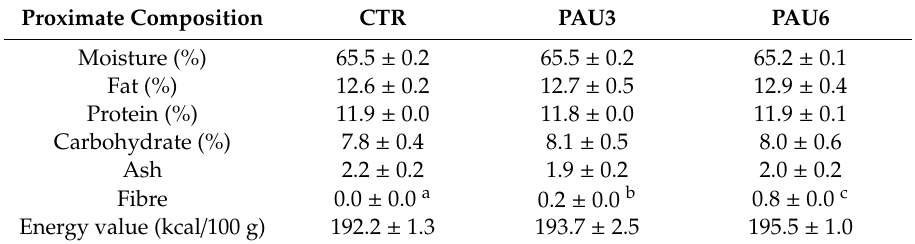
Table 1. Proximate composition (mean ± SD ( n = 3)) of limpets p â t é samples without (CTR—limpets p â t é with butylated hydroxytoluene (BHT)) and with Arbutus unedo fruits extracts (PAU3—limpets p â t é enriched with 3% of A. unedo fruits extract, and PAU6—limpets p â t é enriched with 6% of A. unedo fruits